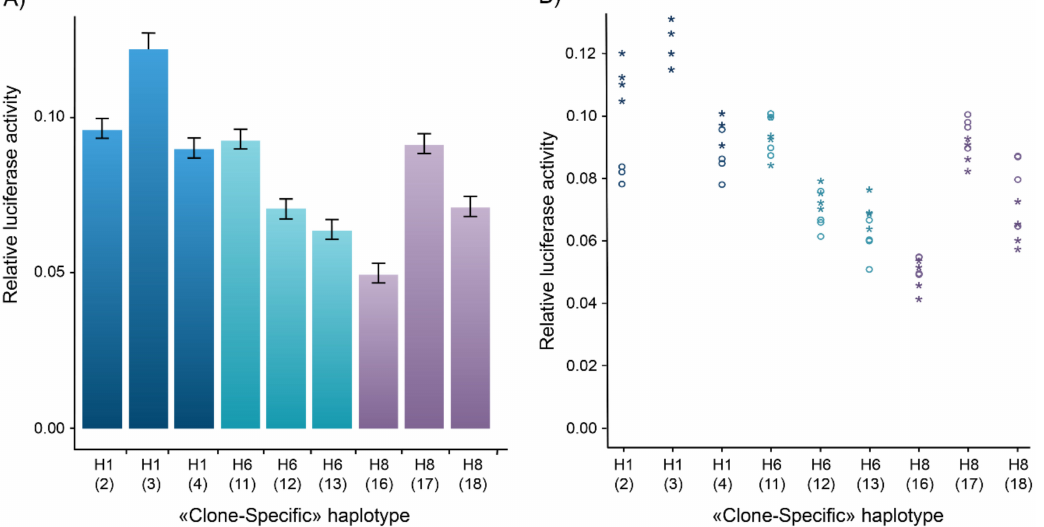
Figure 1. Inter-clone variability observed in transient transfection assays. ( A ) Bars and error bars represent the mean and standard error estimated with the mixed model. ( B ) Stars and circles represent raw data from the two independent experiments respectively. A typical example of the variability in gene expression observed between independent clones of the same haplotype illustrating the relative luciferase activity of clone-specific haplotypes of the PALB2 gene promoter. Three clones of each haplotype were subcloned and transfected in the MCF7 human breast cancer cell line. The three clones containing the same haplotype sequence should display similar gene expression levels. However, we observed a reproducible difference in the reporter gene expression level between the clones of the same haplotype, and for several genes. Inter-clone variability is observed for the PALB2 promoter haplotypes H1-3 vs. H1-4, and H8-16 vs. H8-17. To take this unexpected effect into account, we devised and used the statistical method described in this study (see Supplementary